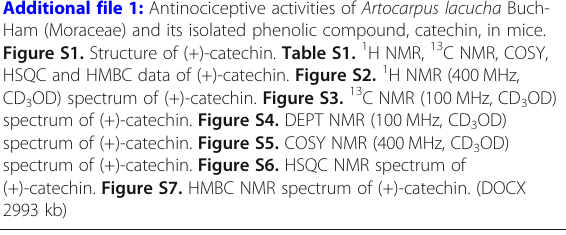
Figure S1. Structure of (+)-catechin. Table S1. 1 H NMR, 13 C NMR, COSY, HSQC and HMBC data of (+)-catechin. Figure S2. 1 H NMR (400 MHz, CD 3 OD) spectrum of (+)-catechin. Figure S3. 13 C NMR (100 MHz, CD 3 OD) spectrum of (+)-catechin. Figure S4. DEPT NMR (100 MHz, CD 3 OD) spectrum of (+)-catechin. Figure S5. COSY NMR (400 MHz, CD 3 OD) spectrum of (+)-catechin. Figure S6. HSQC NMR spectrum